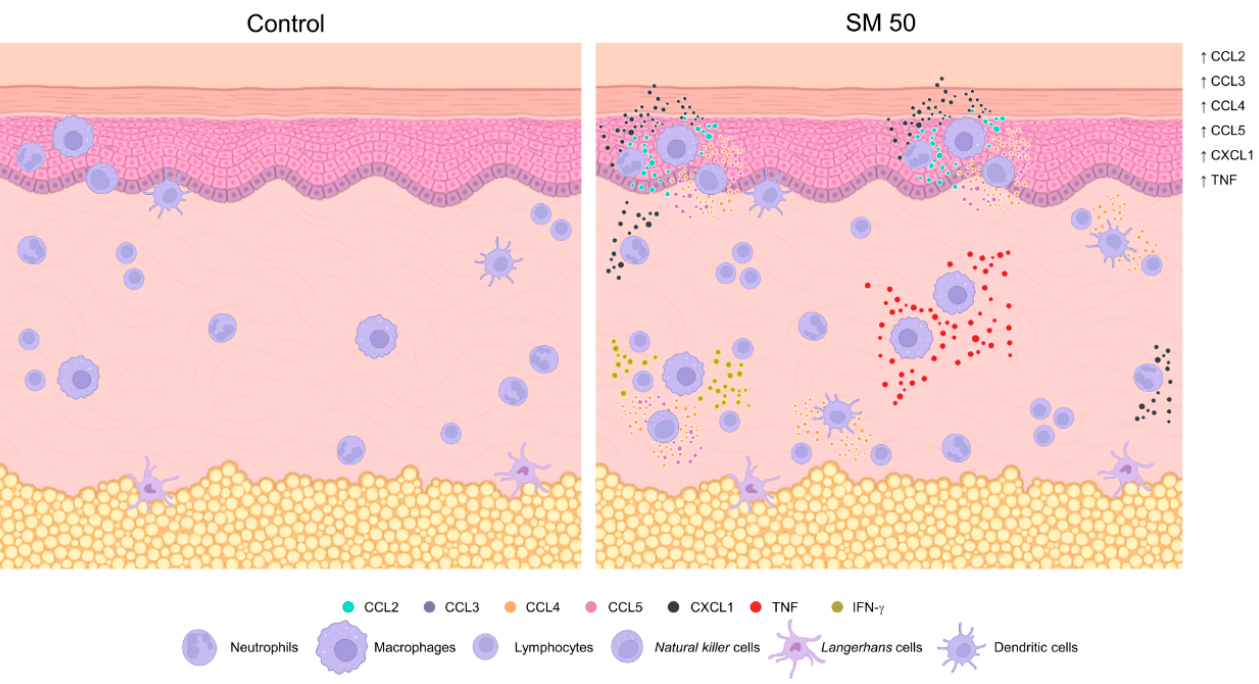
Figure 5. Illustrative figure of the main differences observed in the BALB/c mouse skin 48 h after sensitization with the adjuvant system SM50 (saponin plus monophosphoryl lipid A; the group that received 50% of each adjuvant total dose) in comparison with control group. Figure developed by the authors using the BioRender (available on https://biorender.com accessed on 15 December 2022).